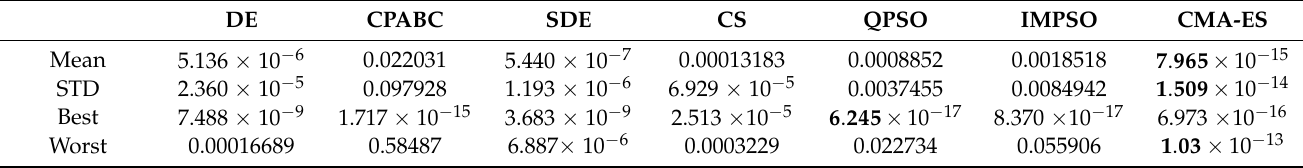
Table 4. Position error results for target point 1. The best results are highlighted in bold.